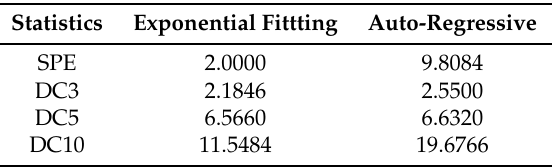
Figure 18. RUL prediction using AR to DC corresponding to D 3 , D 5 and D 10 . Table 3. Mean of absolute RUL prediction